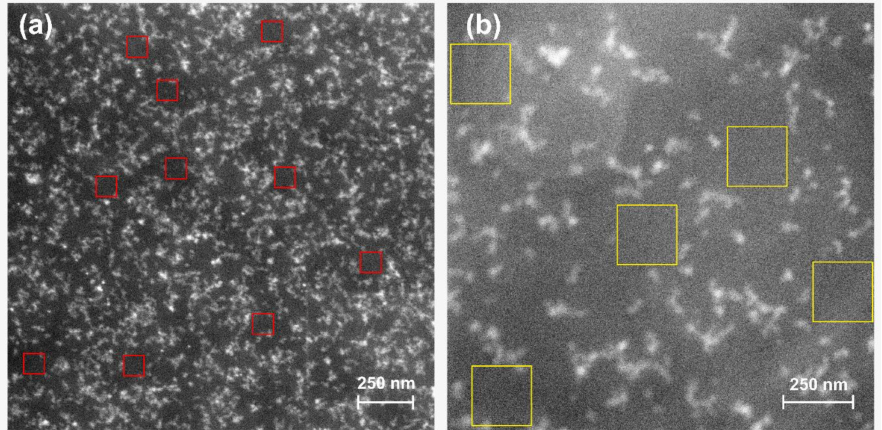
Figure 12. Comparison of the state of dispersion and morphology between SiO 2 prepared at pH 11 with an APTES:DGEBA ratio of ( a ) 1:10 and ( b ) 1:30, both at filler load of 5 wt.%. The red and yellow boxes visualize the size of the free-space lengths (L f ) in each composition (~105 and 205 nm,